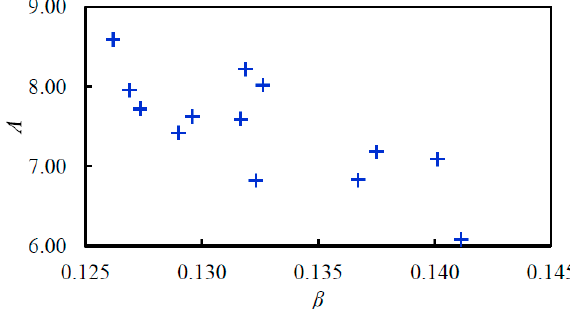
Figure 5. Decreasing figure between β and Λ for constant discharge current I d = 5.0 mA in a helium